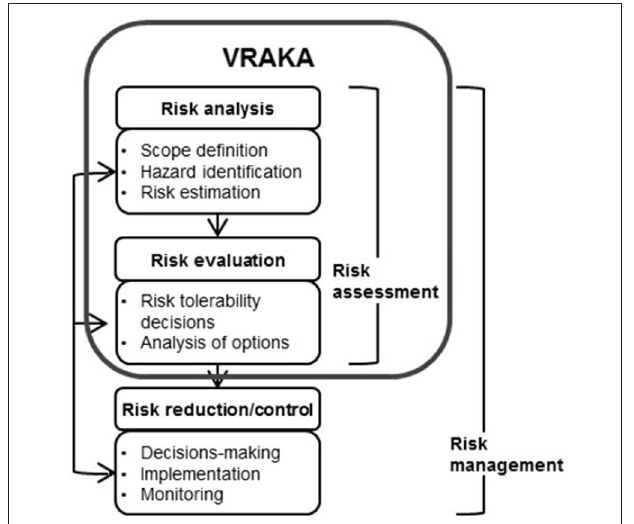
FIGURE 2 | VRAKA in the risk management process.